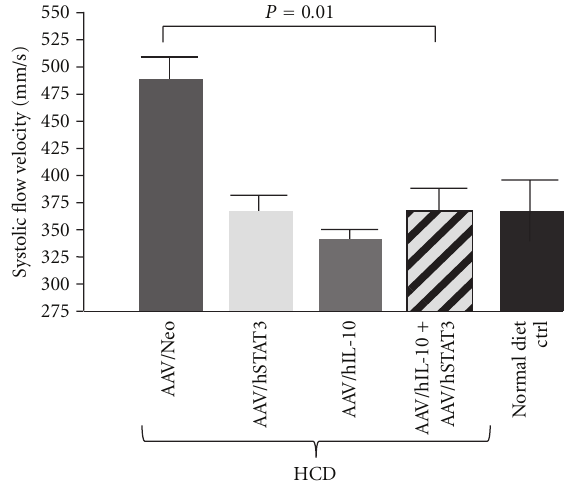
Figure 4: Systolic blood velocity. High-resolution ultrasound (HRUS) was used to measure blood flow velocities in the lumenal center of the abdominal region of the aorta in 3–5 animals from each group. Shown is a quantification of the results. Note that the hSTAT3-treated, the hIL-10-treated, and the hSTAT3-plus-hIL-10- treated animals all had significantly lower blood velocity than the AAV/Neo